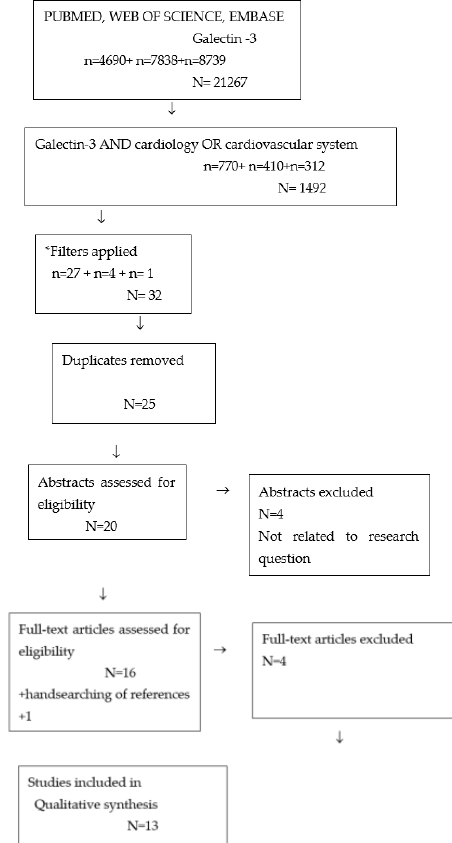
Figure 2. Search strategy. * Filters applied: Child: birth–18 years; Newborn: birth–1 month; Infant: Figure 2 . Search strategy. * Filters applied: Child: birth – 18 years; Newborn: birth – 1 month; Infant: birth – 23 months; Infant: 1 – 23 months; Preschool Child: 2 – 5 years; Child: 6 – 12 years; Adolescent: 13 – birth–23 months; Infant: 1–23 months; Preschool Child: 2–5 years; Child: 6–12 years; Adolescent: 18 years; Publication date: 1 January 2015 – 24 September 2021; Humans. n = results in each database. 13–18 years; Publication date: 1 January 2014–24 September 2021; Humans. n = results in each N = total results. database. N = total